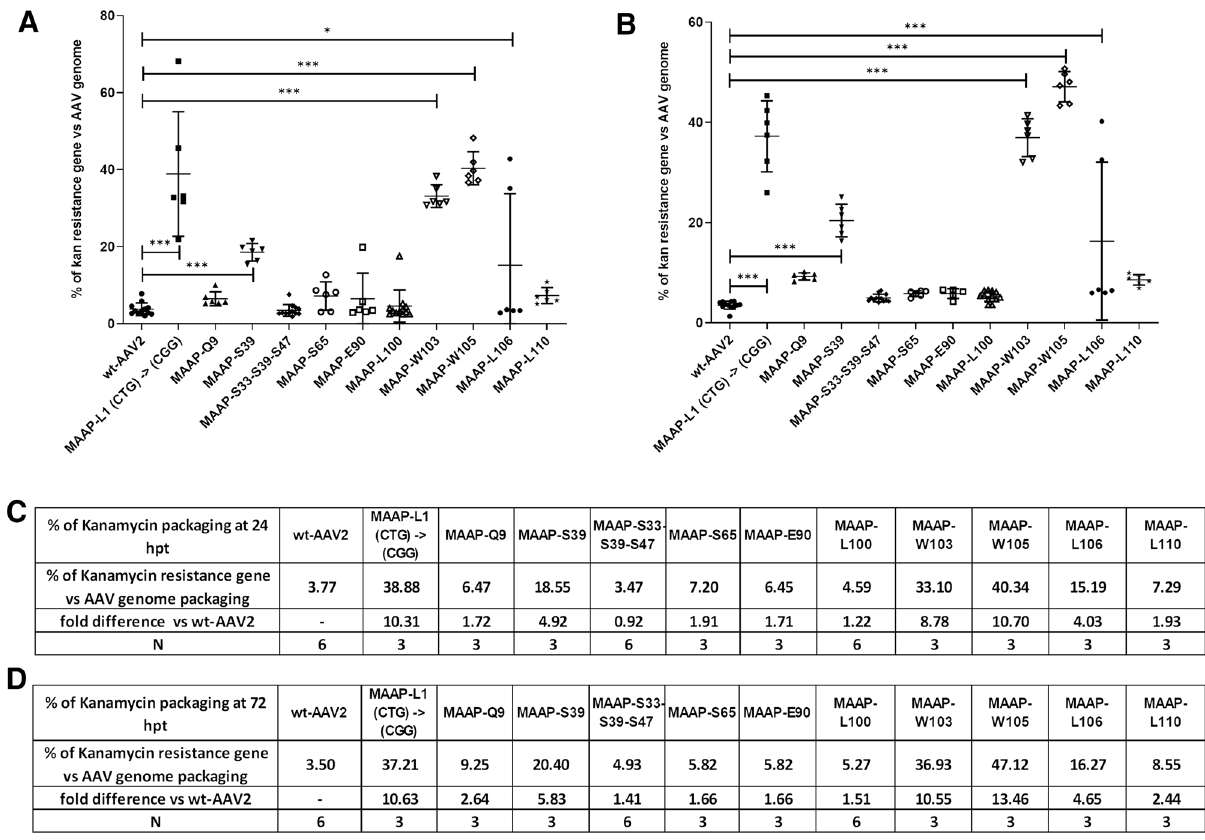
Figure 11. Effect of MAAP inactivation on kanamycin resistance gene packaging. wt-AAV2 or AAV2 MAAP variants and Ad helper plasmids were co-transfected in 293 T cells. At 24 hpt ( A ) and 72 hpt ( B ), AAV vg titers were quantified. In parallel, the kanamycin resistance gene carried by the AAV2 genome and the Ad helper plasmids was quantified. We present the ratio of kanamycin resistance gene packaging relative to the AAV2 genome packaging, expressed as percentage. Individual samples are represented, along with the mean and the standard deviation. Statistical significance between the wt-AAV2 and AAV encoding MAAP mutants was evaluated using ANOVA followed by Dunnett’s multiple comparison test. Tables ( C ) and ( D ) show the average percentage of kanamycin resistance gene packaging relative to AAV2 genome packaging, measured for each virus at 24 hpt and 72 hpt, and the fold difference compared to wt-AAV2. Experiments were performed independently between 3 and 6 times (indicated as N), each time with two